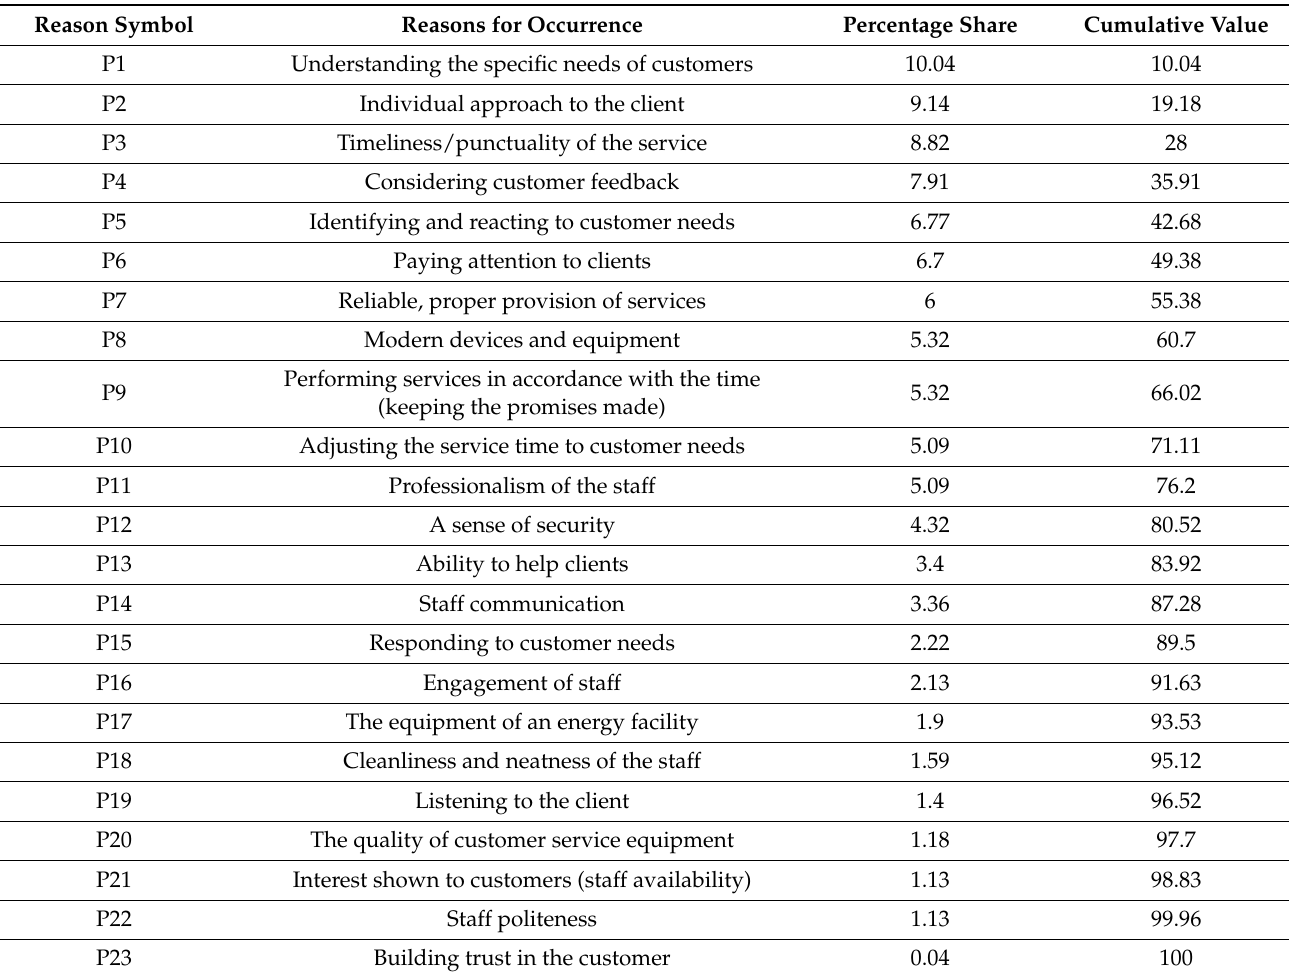
Table 4. Reasons for customer dissatisfaction with the quality of energy services by frequency of